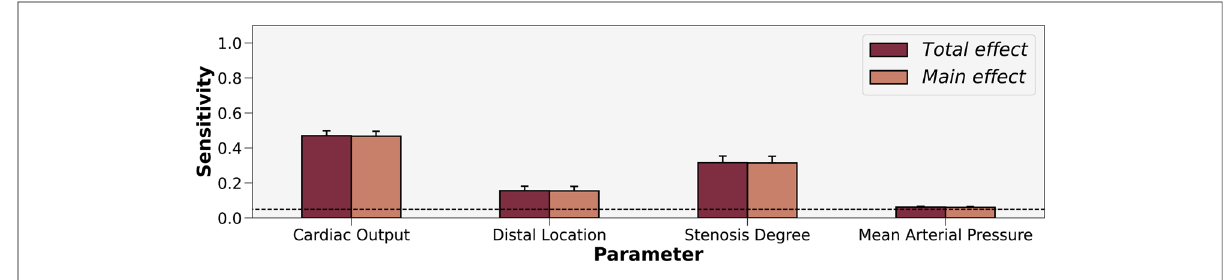
FIGURE 4 Sobol sensitivity indices of patient-tuned parameters on FFR. Total and main effects are displayed for cardiac output, distal location, stenosis degree, and mean arterial pressure. Cardiac output and stenosis degree contribute most to the variance in FFR. The horizontal interrupted line at 0.05 shows the threshold for sensitivity.